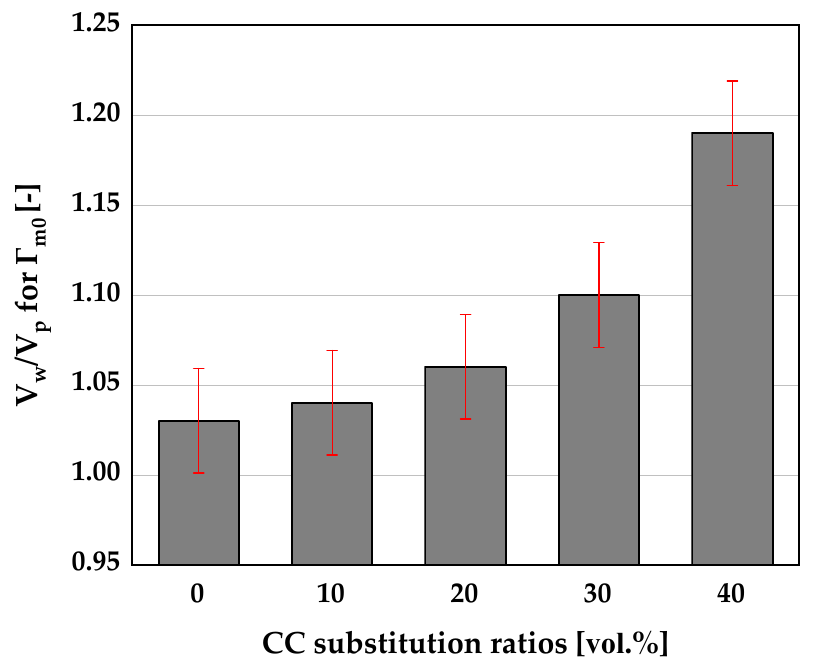
Figure 2. Volumetric water to powder ratio for zero relative flow area depending on the CC substitution rate.